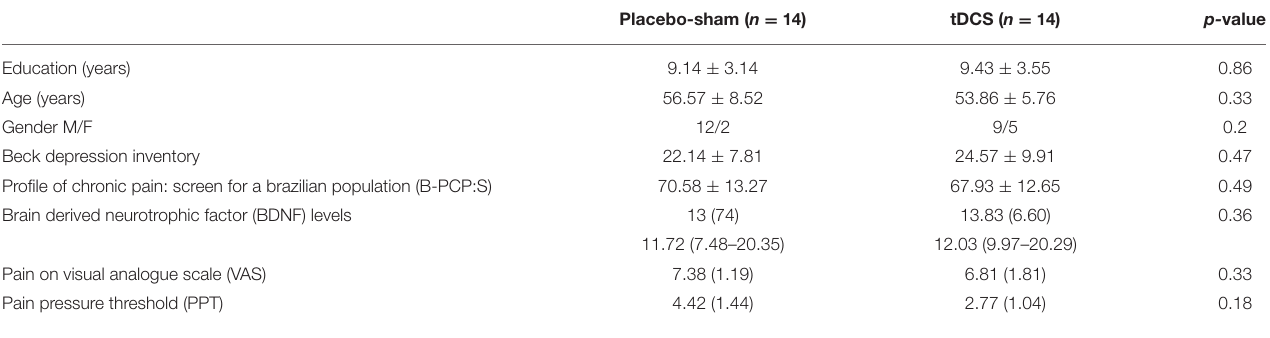
TABLE 1 | Baseline demographic and clinical characteristics of the patients at active or sham